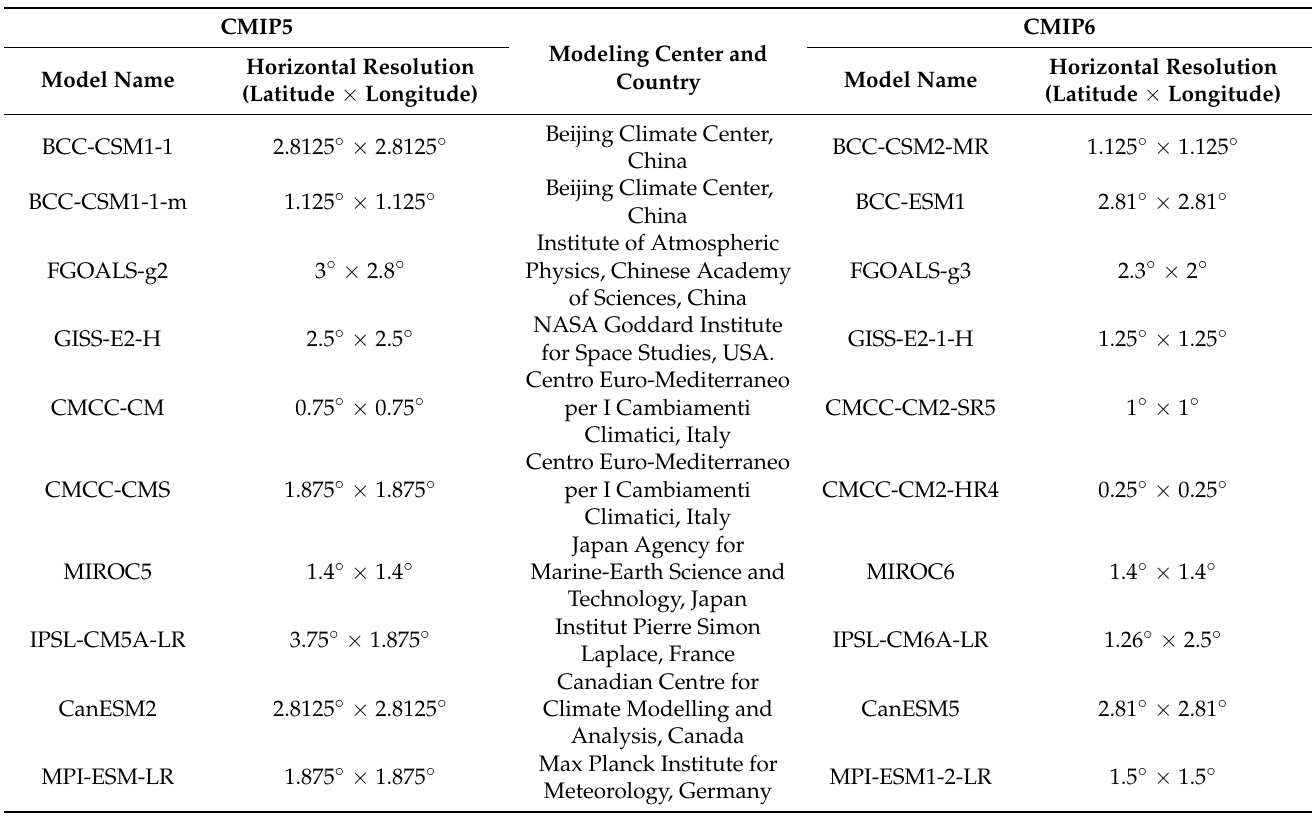
Table 2. Studied GCMs from CMIP5 and